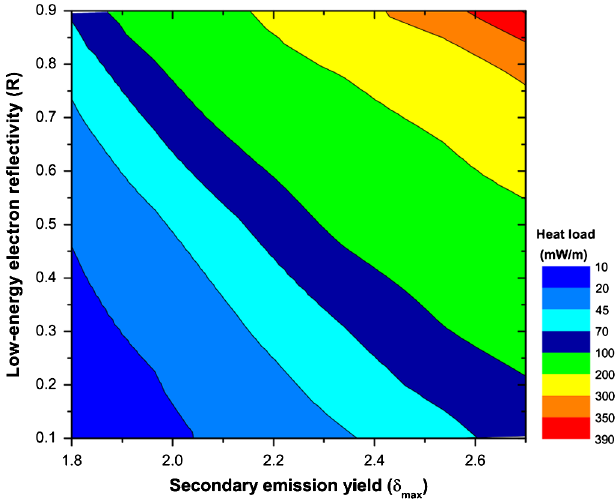
FIG. 10. Heat-load contour plot for 50 ns bunch spacing at 3.5 TeV.